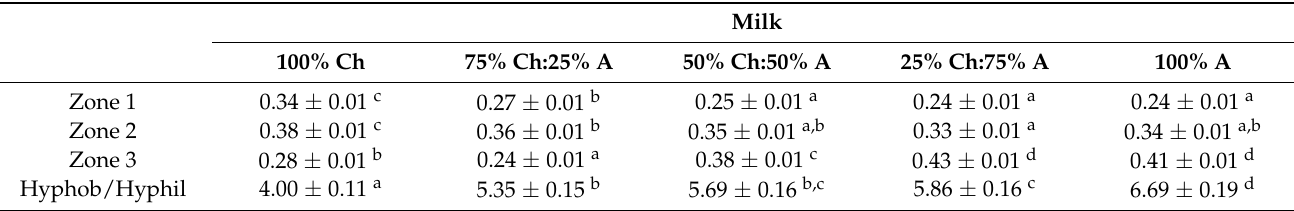
Table 1. Relative areas of hydrophilic and hydrophobic zones of chromatograms from permeates of soluble extract in Zamorano cheese made with milk from Churra (Ch) and Assaf (A) breed after 240 days’